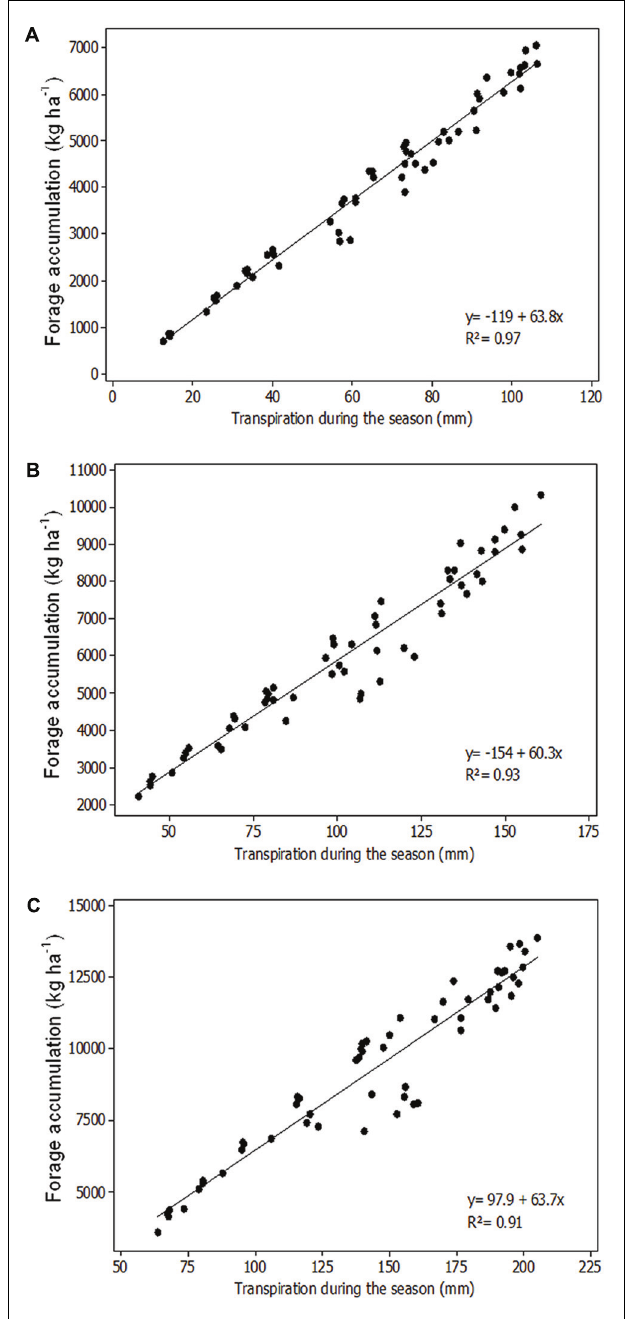
FIGURE 4 | Relation between simulated total transpiration and pearl millet forage accumulation for Bom Conselho (A) , Nossa Senhora da Gloria (B) , and Sao Bento do Una (C) . Individual points represent the four cultivars and planting